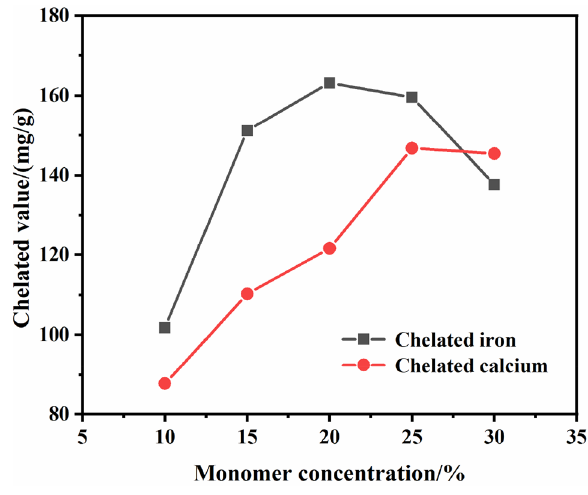
Figure 1. Effect of acrylic monomer concentration on chelated